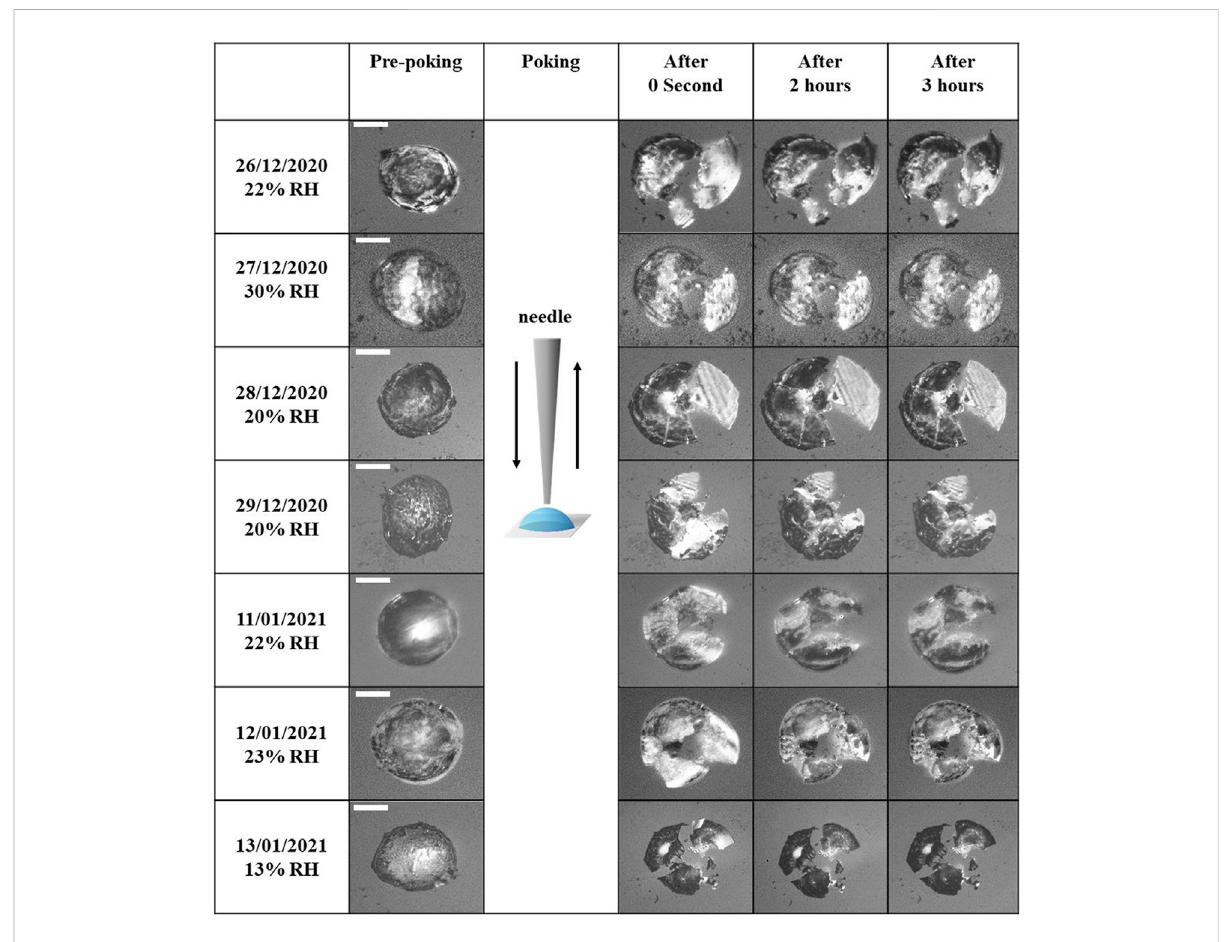
FIGURE 4 Optical images of pre-poking, poking, and post-poking for polluted PM 2.5 fi lter samples during the poke-and- fl ow experiment. The scale bar is 10